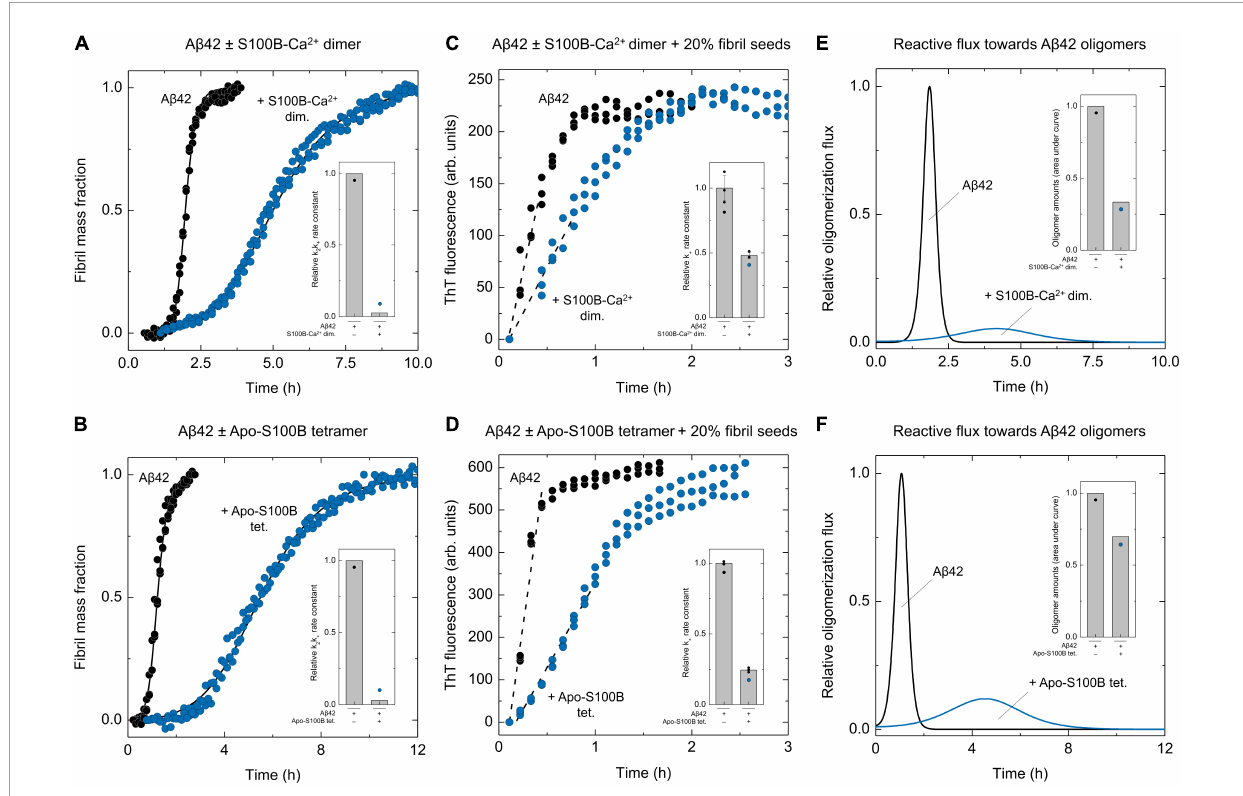
FIGURE2 Effect of S100B dimer and tetramer over A β 42 oligomerization flux distributions. Normalized kinetic traces and global fits (solid lines) of unseeded ThT-monitored aggregation of A β 42 [6 µ M in panel (A) or 4 µ M in panel (B) ] in the absence and presence of (A) dimeric S100B-Ca 2 + (S100B:A β 42 = 5.8) or (B) tetrameric apo-S100B (S100B:A β 42 = 0.5) with indication of the relative secondary pathways combined rate constants ( k 2 k + , insets). Kinetic traces of high-seeded (20% A β 42 fibrils). ThT-monitored aggregation of A β 42 [6 µ M in panel (C) or 4 µ M in panel (D) ] in the absence and presence of (C) dimeric S100B-Ca 2 + (S100B:A β 42 = 5.8) or (D) tetrameric apo-S100B (S100B:A β 42 = 0.5), depicting the plot regions used for linear fits (dashed lines) and the calculated relative elongation rate constants ( k + , insets). Error bars represent standard deviation of three experiments. Relative A β 42 oligomerization flux/nucleation rate distributions (solid lines) in the absence/presence of (E) dimeric S100B-Ca 2 + (S100B:A β 42 = 5.8) or (F) tetrameric apo-S100B (S100B:A β 42 = 0.5) and total amounts of oligomers calculated by integration of each distribution in respect to time